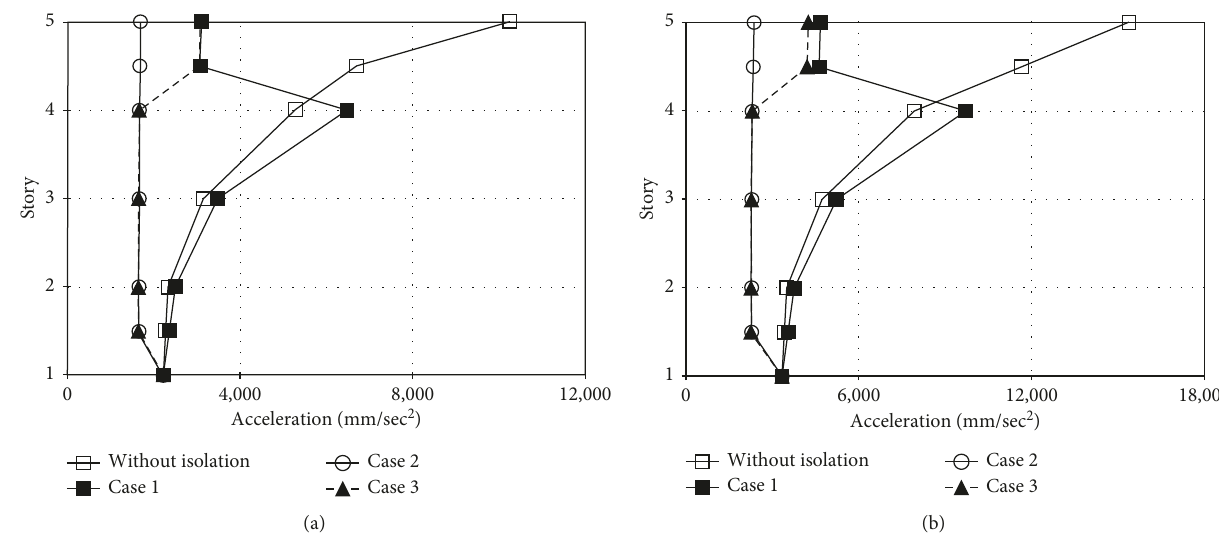
Figure 14: Average maximum acceleration result. (a) DBE. (b) MCE. Table 10: Average story shear under design-based earthquake (mm).